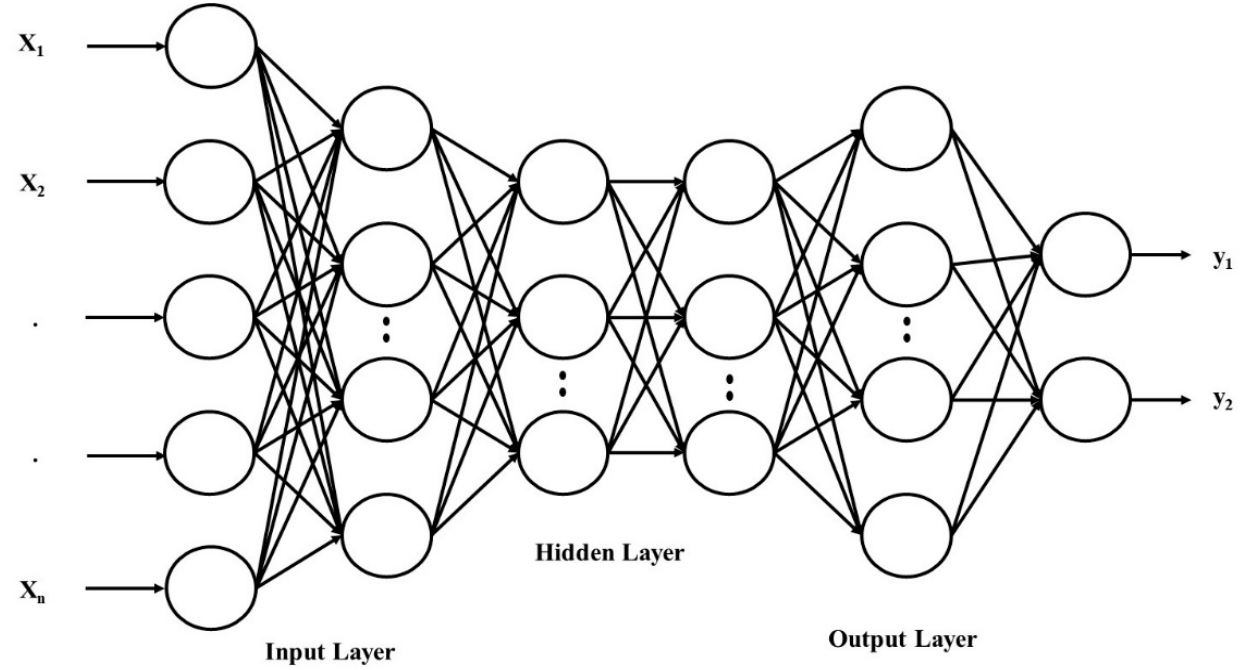
Figure 5. The general architecture of deep neural network (DNN).